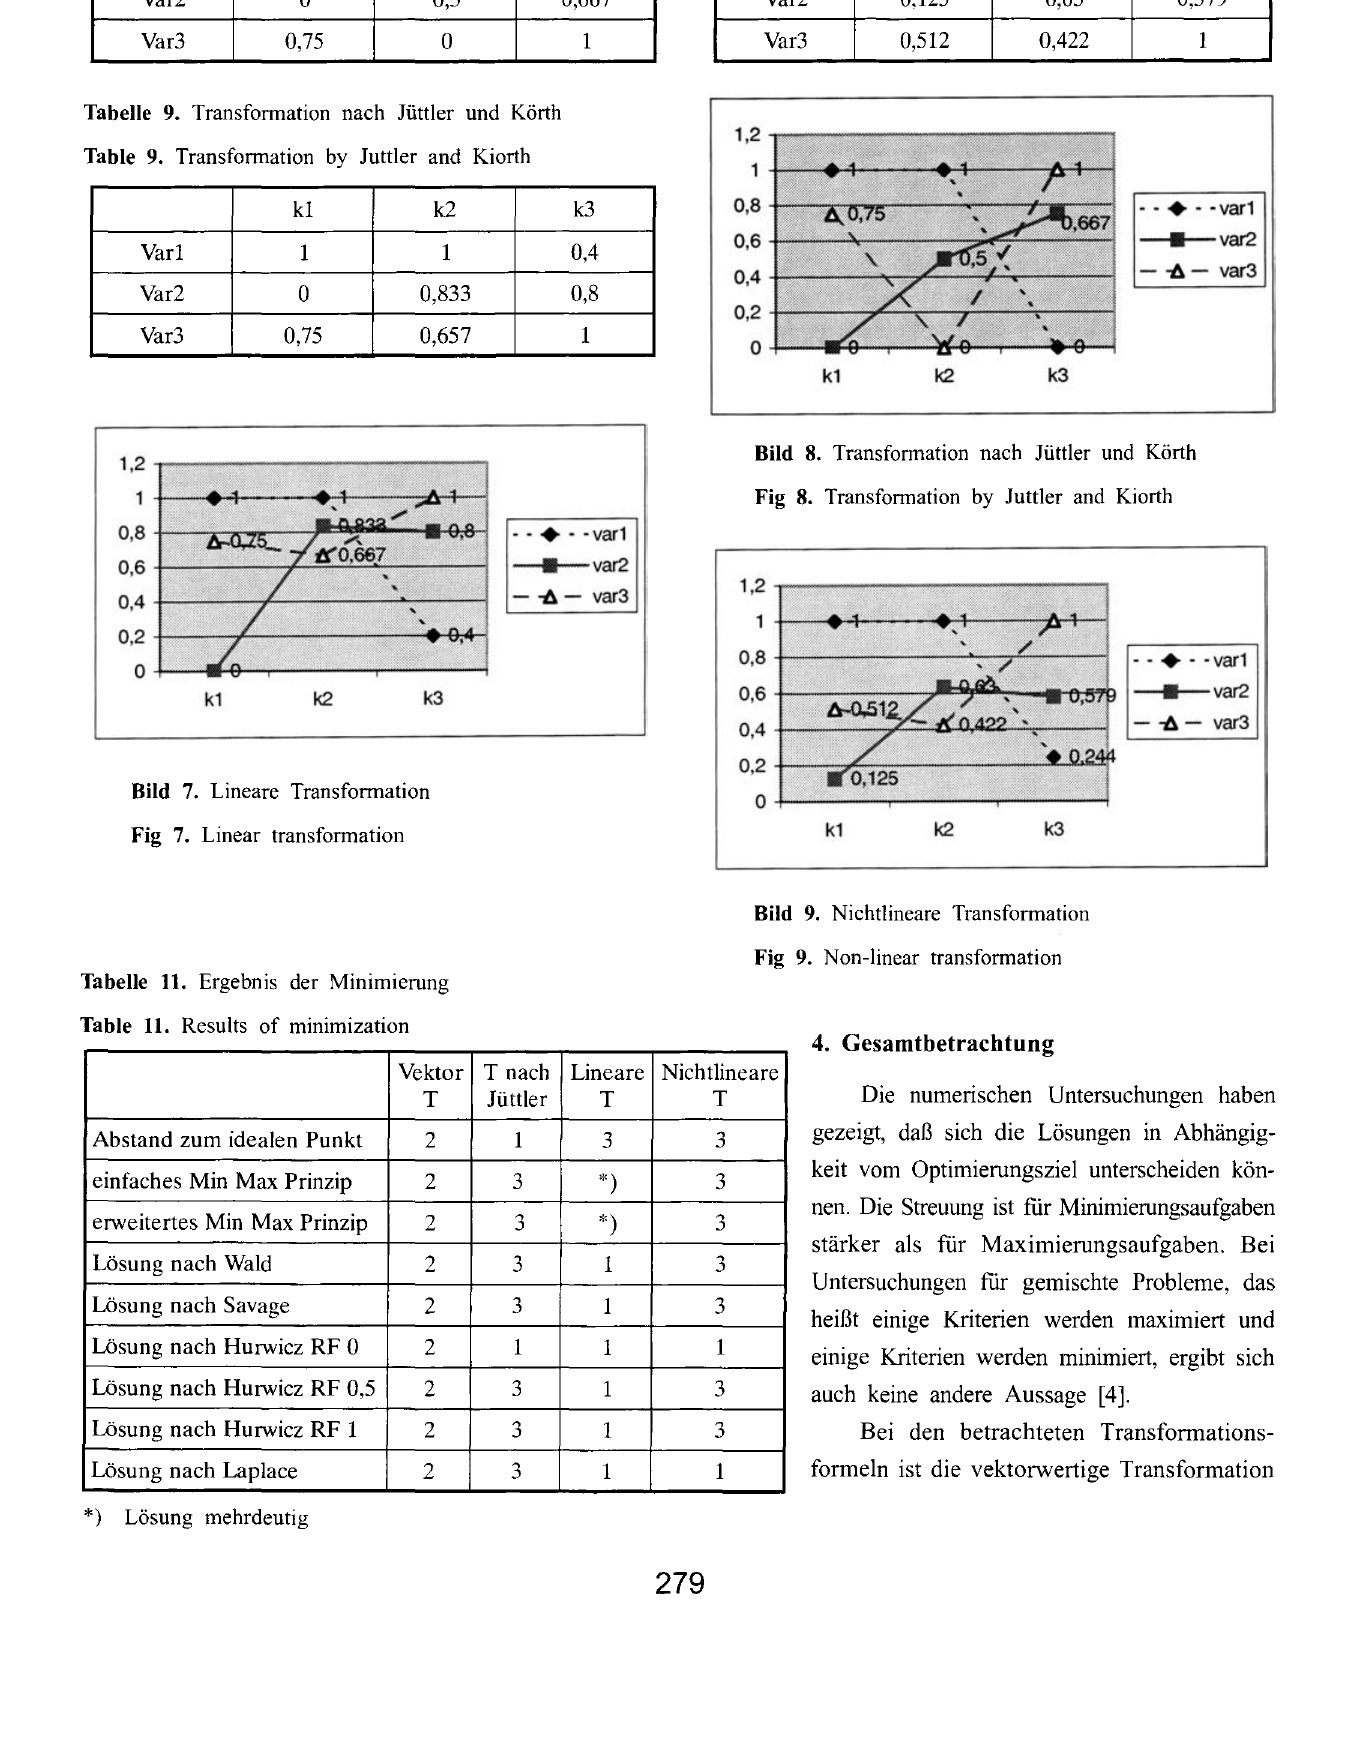
Tabelle 8. Lineare Transformation Table 8. Linear transformation